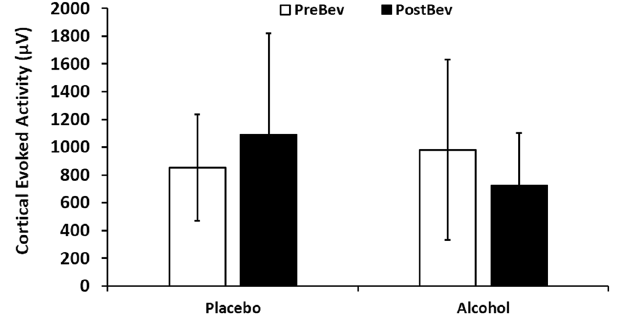
Figure 2. Cortical evoked activity (CEA) before (white bars) and after (black bars) beverage ( μ V) for the placebo and alcohol conditions (n = 14). Error bars represent the standard deviations. Neither placebo or alcohol beverage produced a significant change in CEA in the DLPFC compared to before beverage. Following beverage consumption, there was a significant difference between cortical evoked activity in the alcohol and placebo groups.